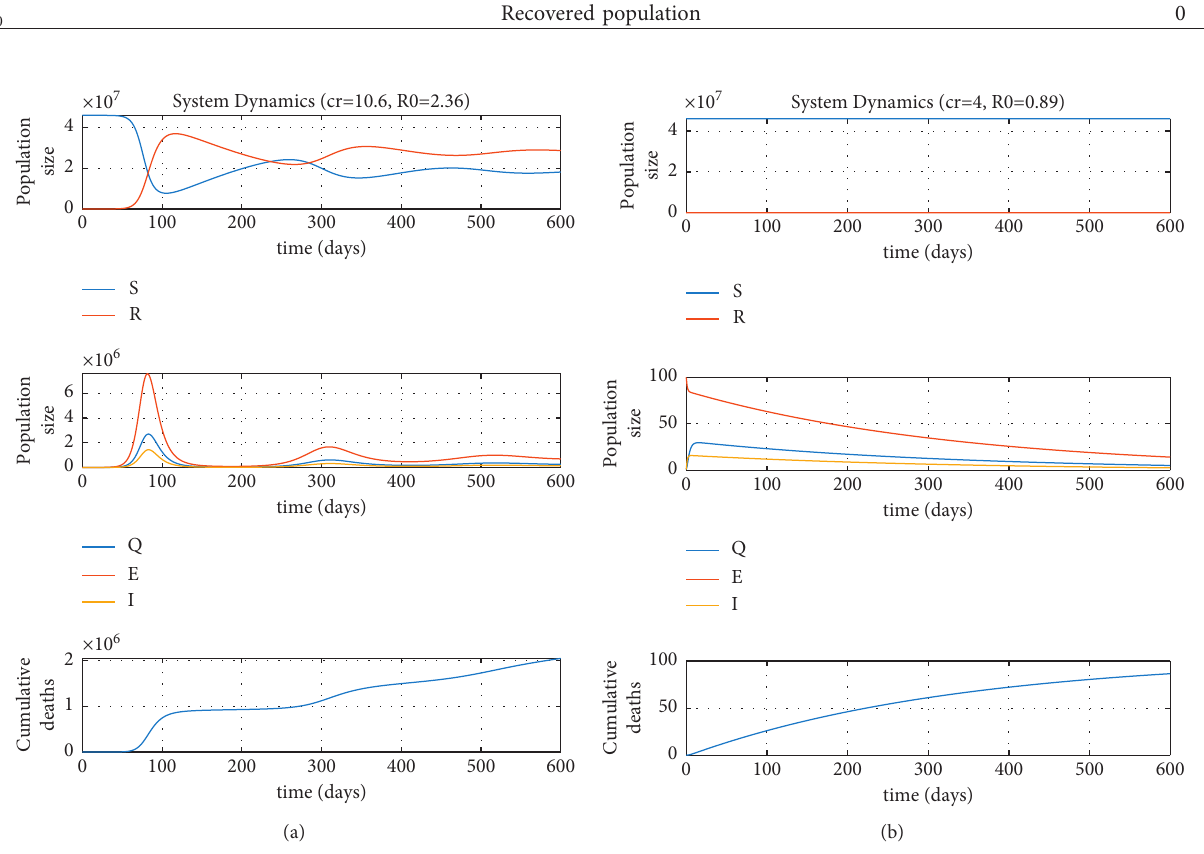
Figure 2: S , R , E , I , and Q population sizes with respect to time when c